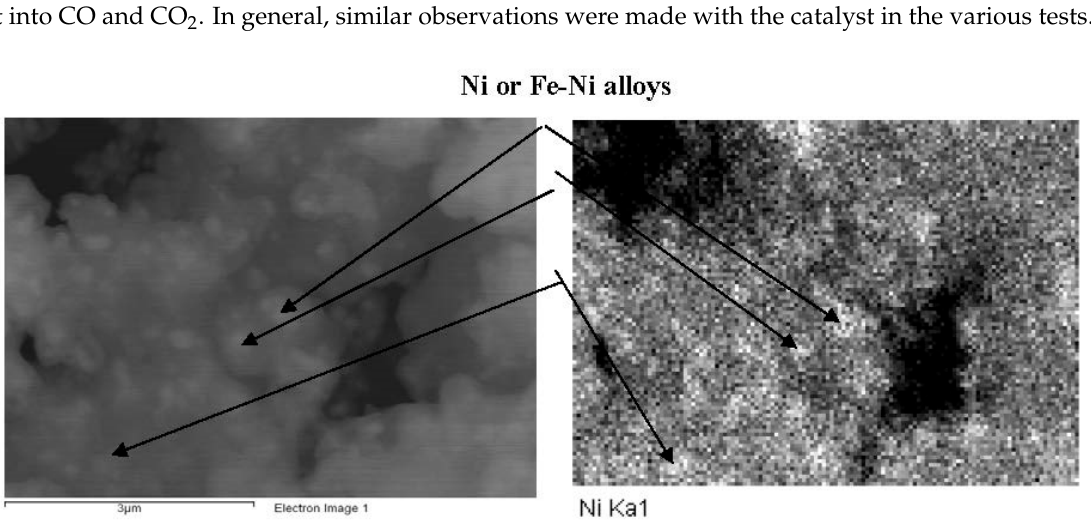
Figure 7. Micrographs of Ni-UGSO after bio-oil MemU SR at 800 °C: ( A ) WHSV = 1.7 g/g cat /h; and ( B ) WHSV = 6.6 g/g cat /h.